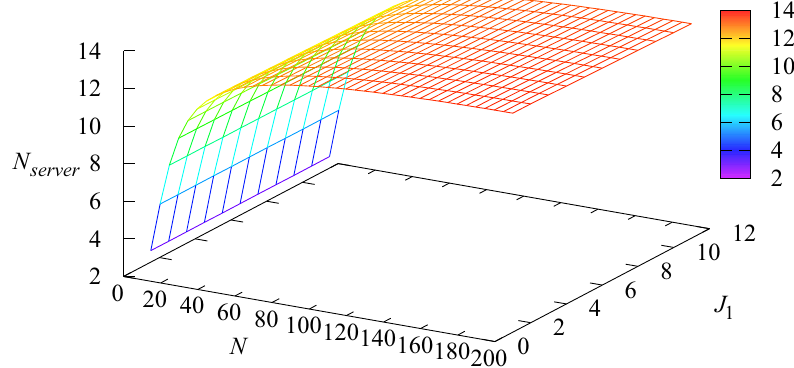
Figure 3. Dependence of the average number of busy servers N server on N and J 1